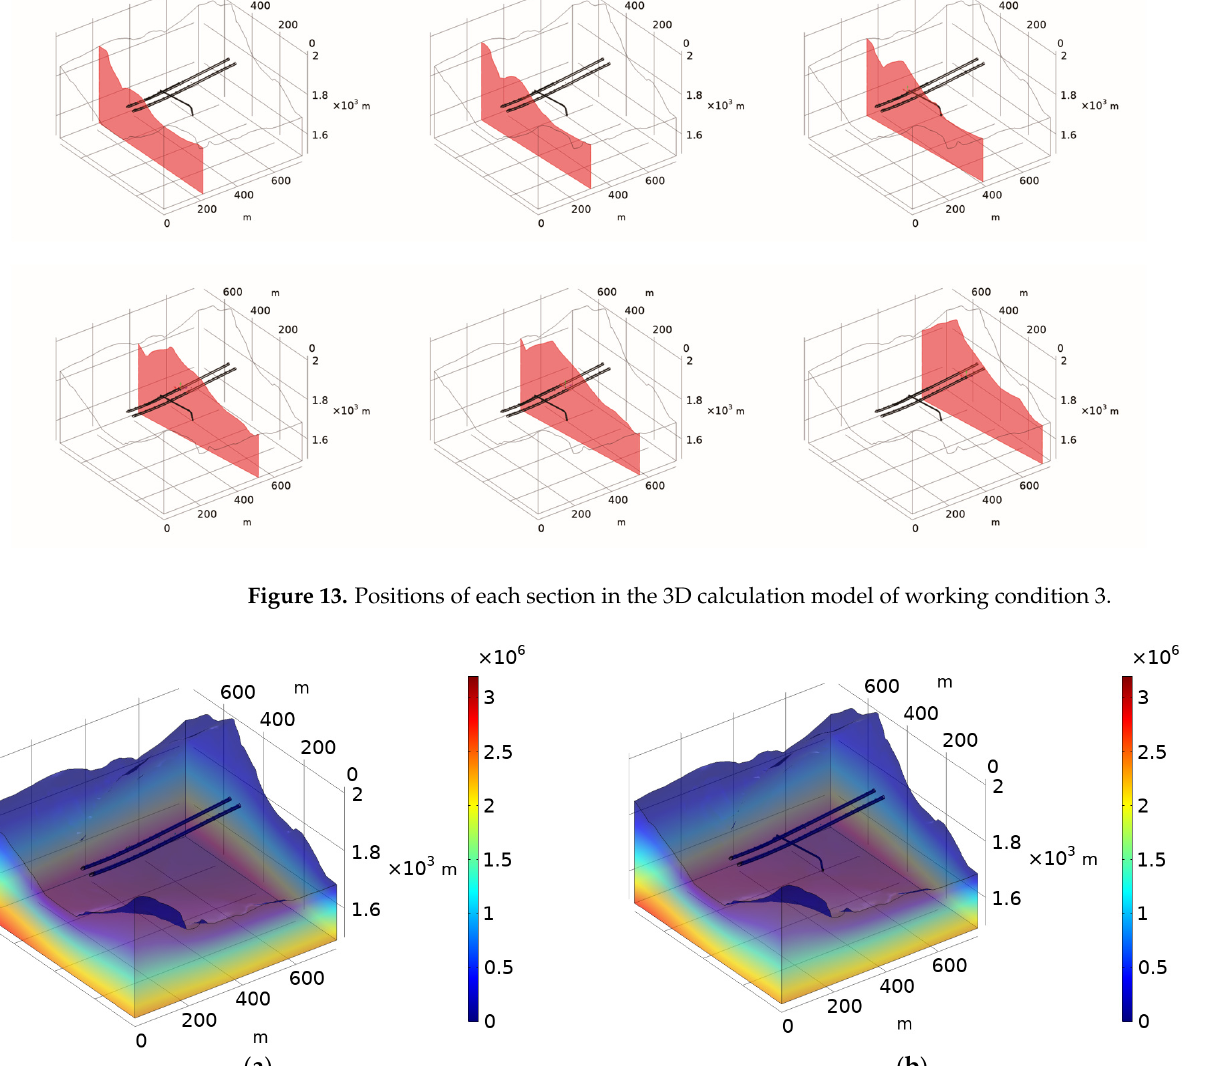
Figure 14. Water pressure in the mountain (Unit: Pa): ( a ) no inrush prevention and control was carried out; ( b ) prevention and control of water gushing.